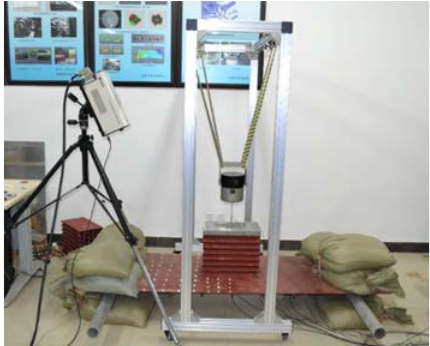
Figure 17: Modal test of the auxetic cellular base.